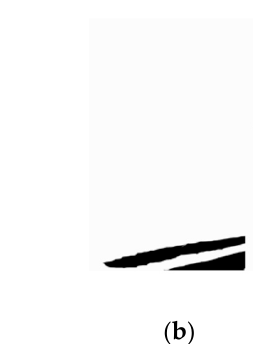
Figure 6. The region in which the occluded person’s shadows are located. ( a ) The RGB image is divided into three regions and ( b ) the difference image is obtained by subtracting the background image from R l . It includes the occluded person’s shadow.